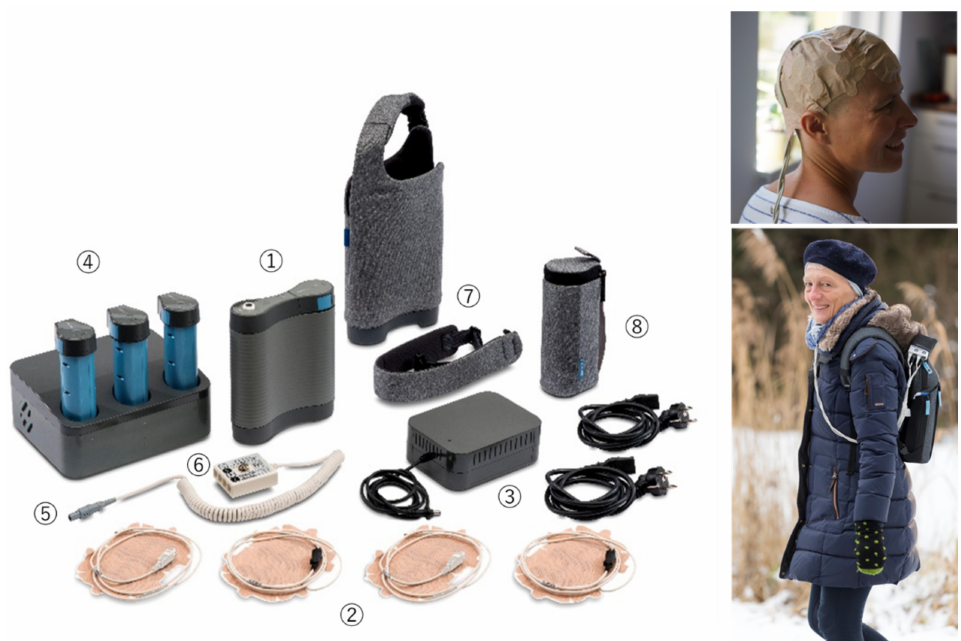
Figure 2. Optune ® Treatment Kit. The system contains an electric field generator to be connected to 2 pair of transducer arrays which are applied directly to the shaved scalp and a battery pack can be carried in a bag. 1. Electric Field Generator (the device), 2. Transducer Arrays, 3. Plug in Power Supply and Power Cords, 4. Portable Batteries and Charger, 5. Connection Cable, 6. Connection Box, 7. Shoulder Bag and Strap, 8. Reproduced with permission from Novocure Inc [14]. Copyright 2021 Novocure—all rights reserved. Permission for global image use was obtained from the